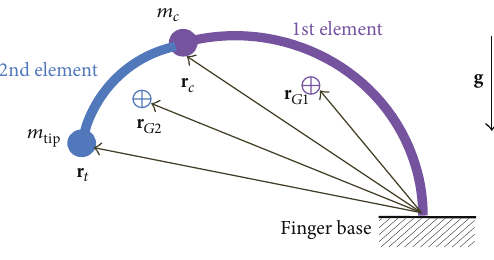
Figure 6: Gravitational potential